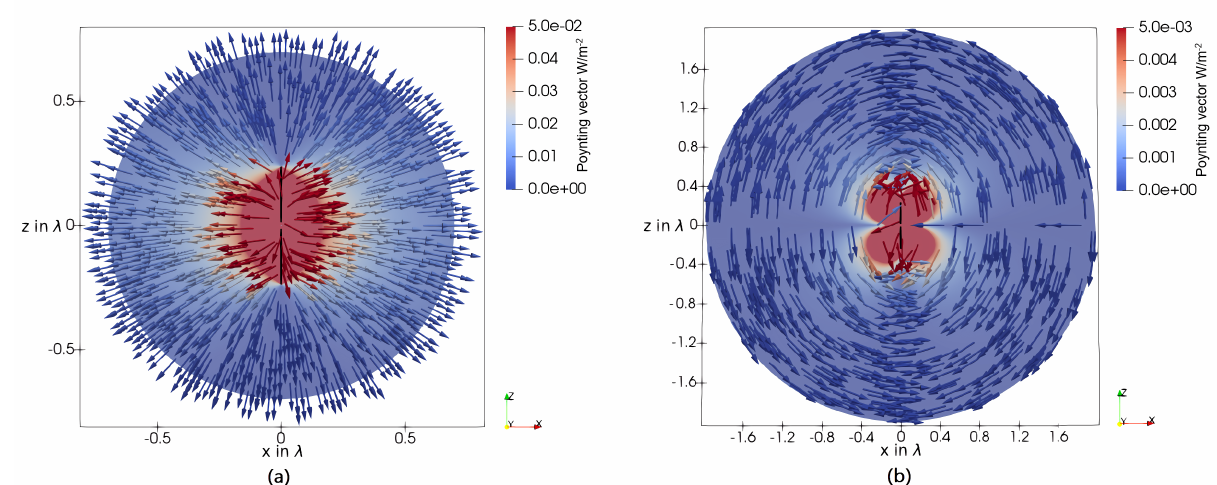
Figure 8. ( a ) The real part of the Poynting vector in the E-plane of a dipole antenna with an overall length of 0.5 λ . ( b ) The imaginary part of the Poynting vector in the E-plane of a dipole antenna with an overall length of 0.5 λ .